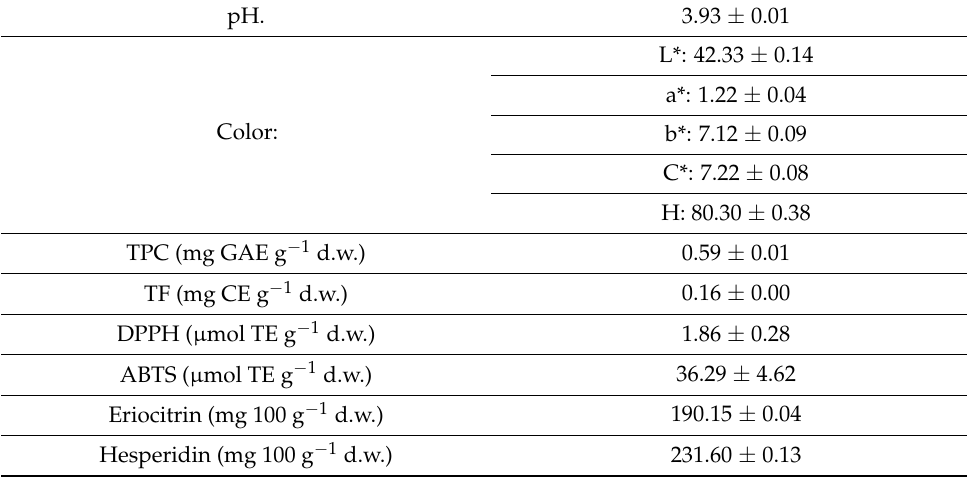
Table 2. Physicochemical characterization of LP E